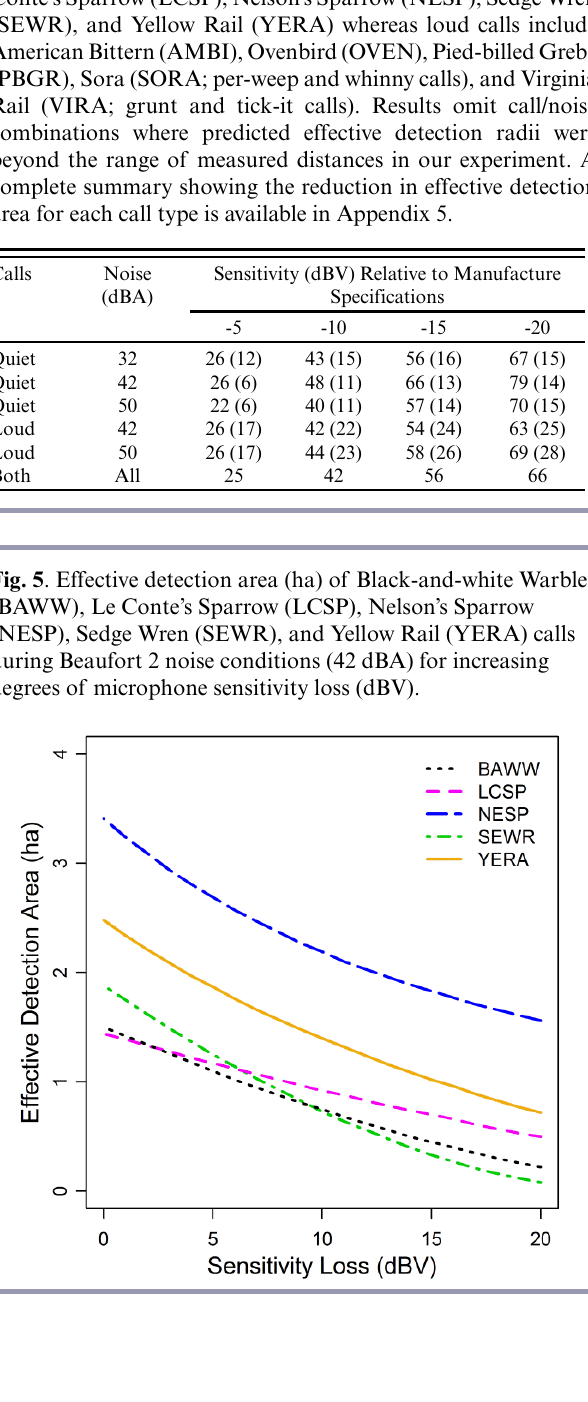
Table 4 . Percent reduction (and standard deviation) in the effective